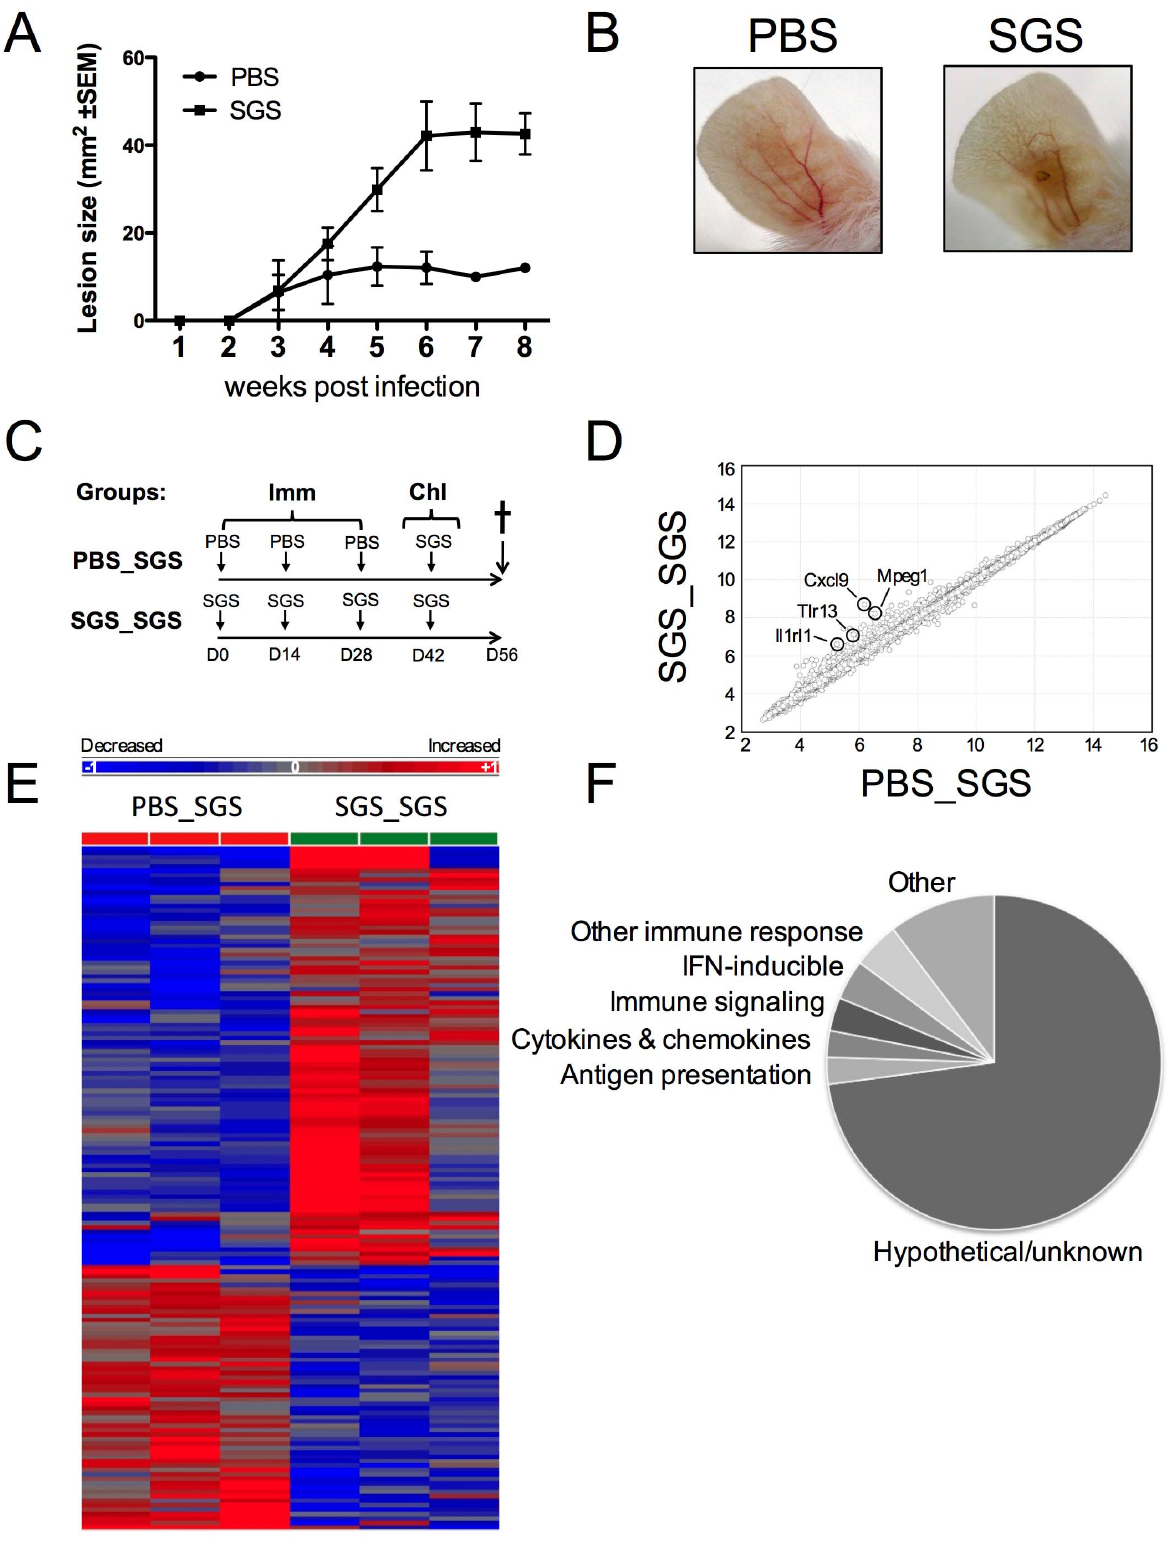
Figure 1. Gene categories modulated by SGS pre-immunization. BALB/c mice were inoculated 3 times in the right ear pinna every 2 wks with SGS from 1 pair of Lu. intermedia salivary glands and then challenged 2 wks later with Lu. intermedia SGS plus 1 6 10 6 L. braziliensis parasites. (A) Lesion development was monitored weekly. Each point is the mean 6 SEM of 5 animals per group. (B) Lesion images of ear pinna at 8 wks p.i. and these data are representative of two independent experiments. (C) BALB/c mice were pre-immunized (Imm) 3 times in the right ear every 2 wks with Lu. intermedia SGS or PBS and then challenged (Chl) in the left ear 2 wks later with Lu. intermedia SGS. The challenged left ears were collected after 2 wks,